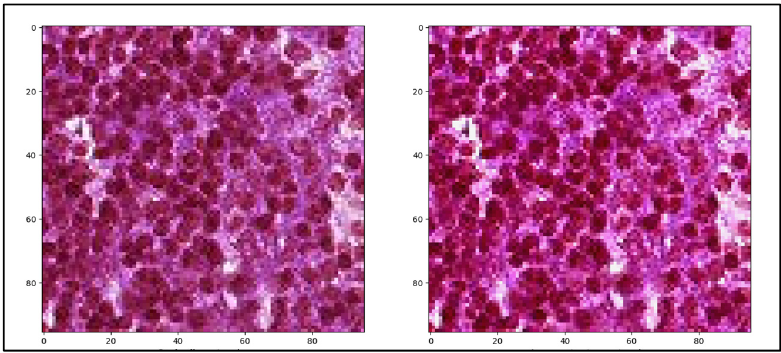
Figure 2. Contrast adjustment applied on image.